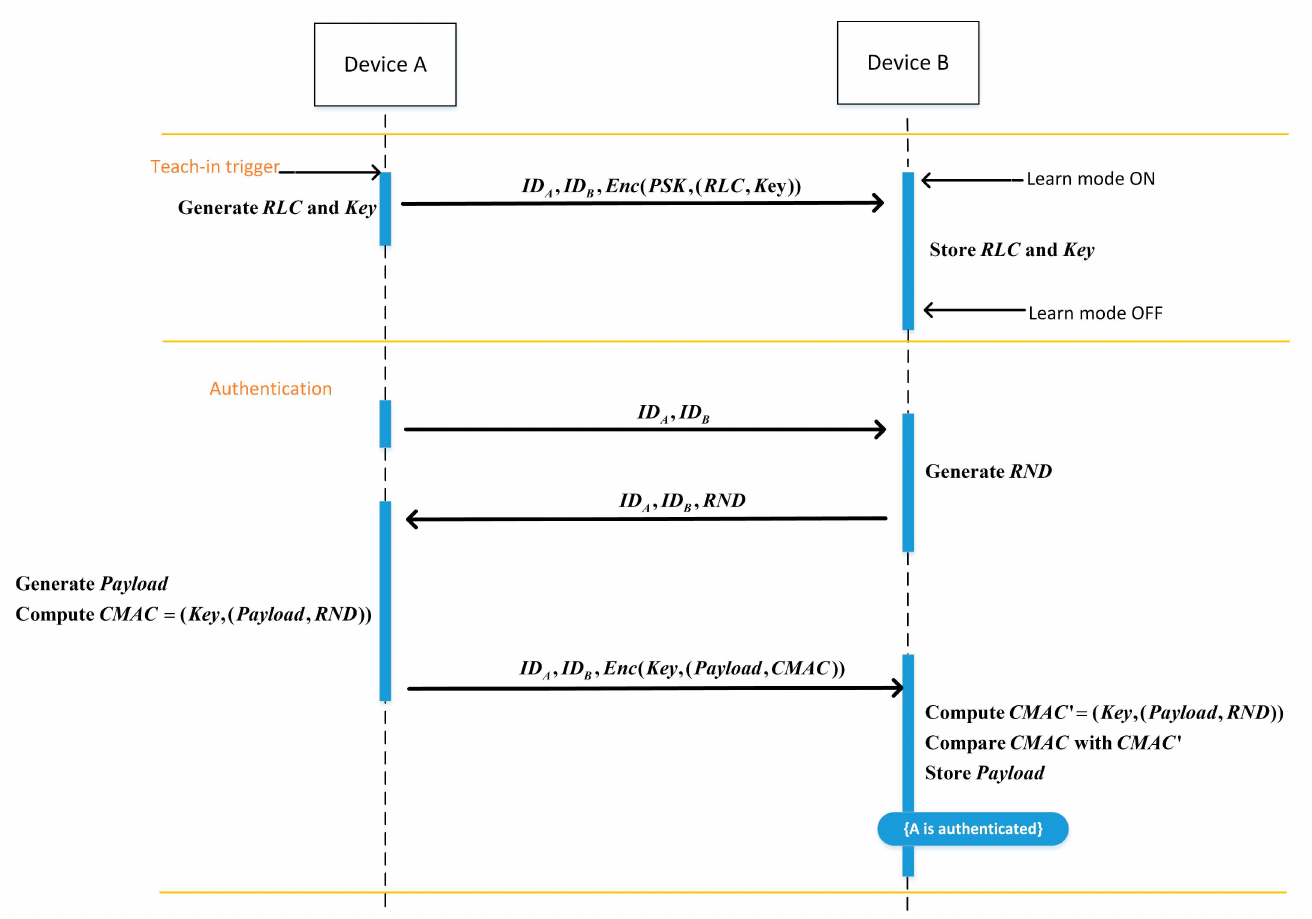
Figure 1. EnOcean protocol data